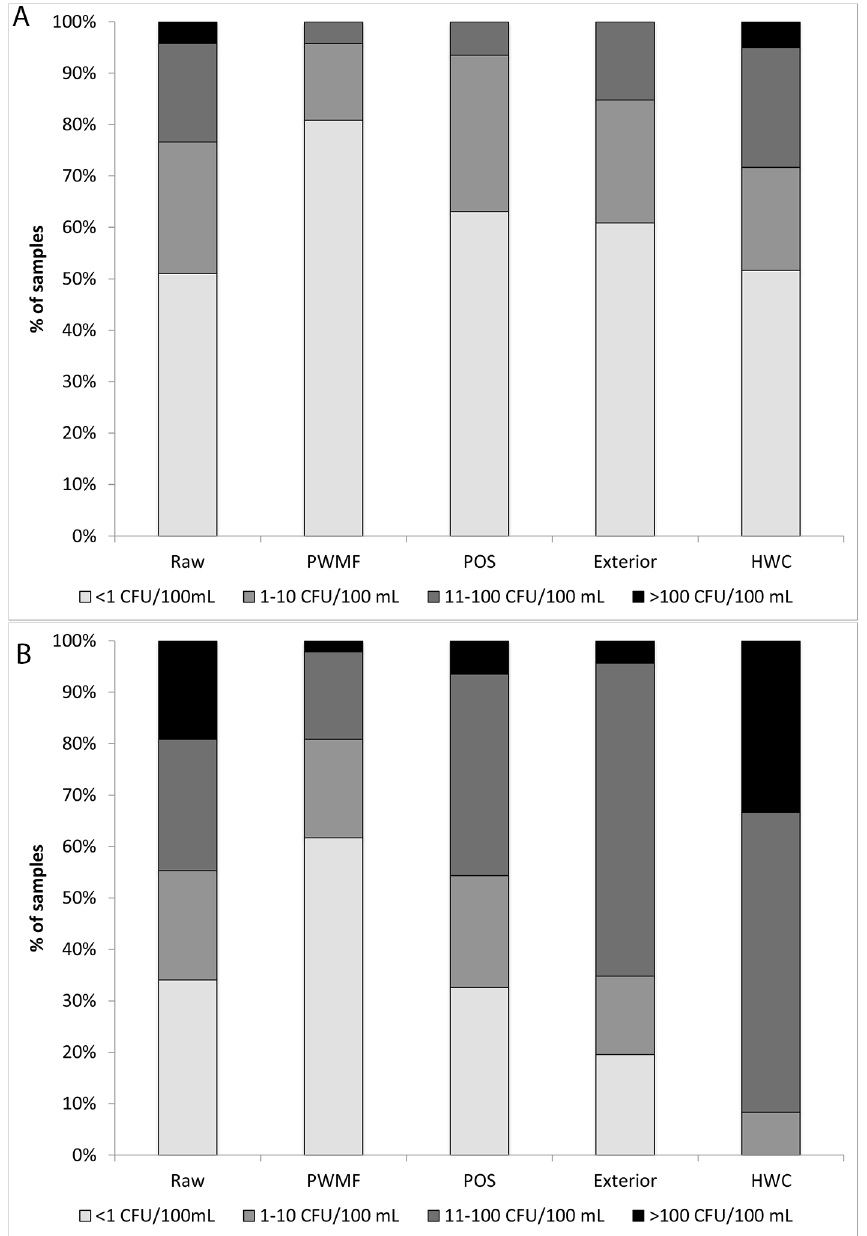
Fig 1. Bacterial concentrations in samples by risk category. Concentrations of A) E . coli and B) Total coliforms (CFU/100 mL) measured in raw water and finished packaged sachet water (PSW) samples at the packaged water manufacturing facility ( “ Raw ” and “ PWMF ” , respectively) and in PSW samples as well as on the exterior of PSW samples at the point of sale ( “ POS ” and “ Exterior ” , respectively) and in household water for consumption ( “ HWC ”